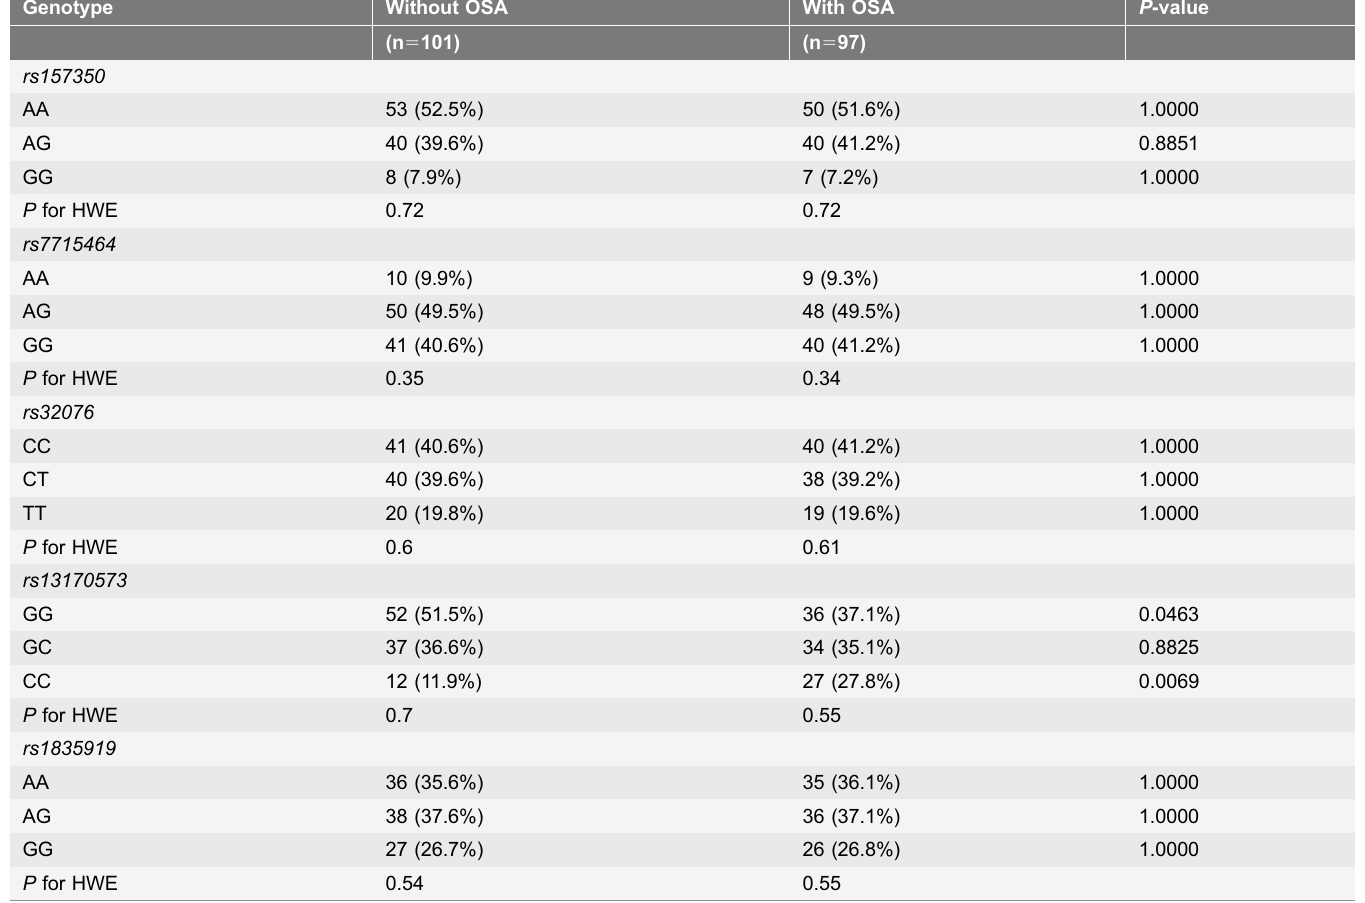
Table 3. Genotype frequencies in OSA patients and